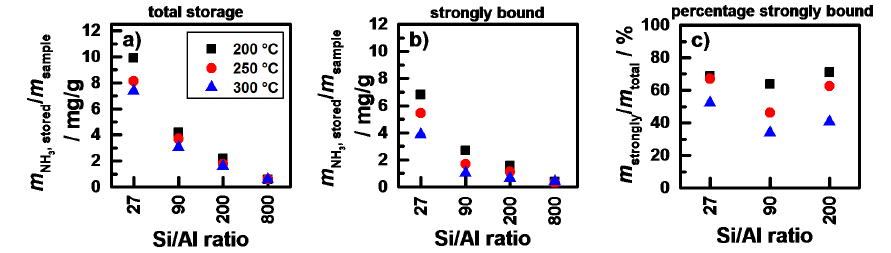
Figure 3. Ammonia storage behavior as a function of the Si / Al ratio at 200, 250 and 300 ◦ C: (a) total storage, (b) strongly bound ammonia, and (c) percentage of strongly bound ammonia in relation to total storage.